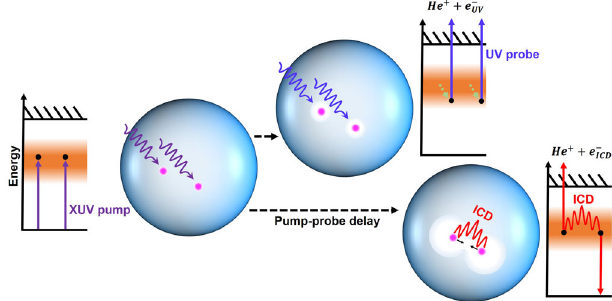
FIG. 1. Atoms in the He droplet are excited to the 1 s 2 p droplet band by the XUV pump pulse. After internal relaxation, bubbles are formed around the excited atoms. The two bubbles are accelerated toward each other, leading to a merging of the bubbles and ICD (bottom scenario). A time-delayed UV pulse is used to probe the dynamics of the process. If the UV probe pulse comes before ICD occurs, the pulse ionizes the excited atoms, thereby halting the ICD process (top scenario at short pump-probe delay). The He droplet is represented by the large blue circles, and excited atoms and bubbles are represented by pink and white circles, respectively. The energy-level diagrams illustrate the energetics of processes. Using photoelectron spec- troscopy, one can differentiate ICD electrons and UV-ionized electrons as shown in Fig.